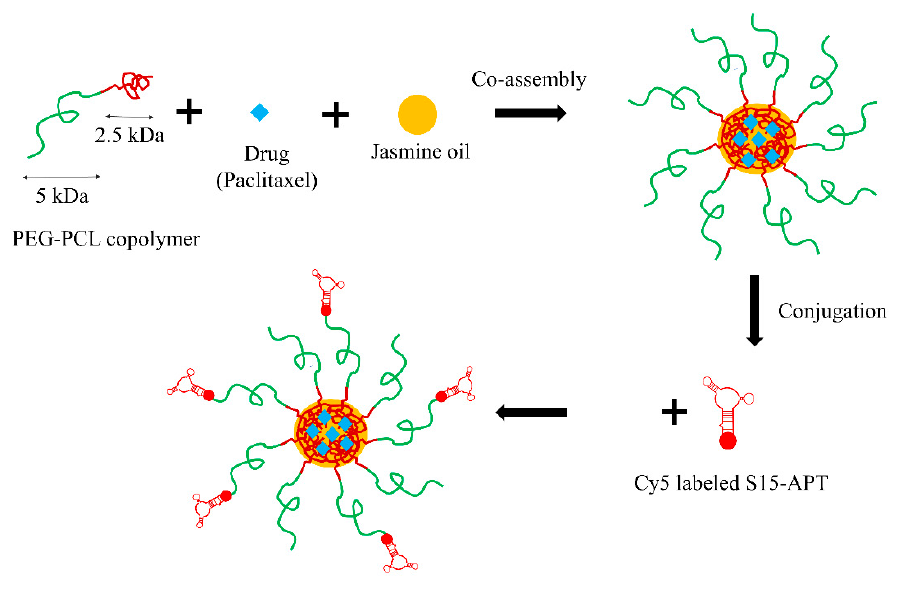
Figure 1. Schematic structure of the APT-NPs co-encapsulating JO and